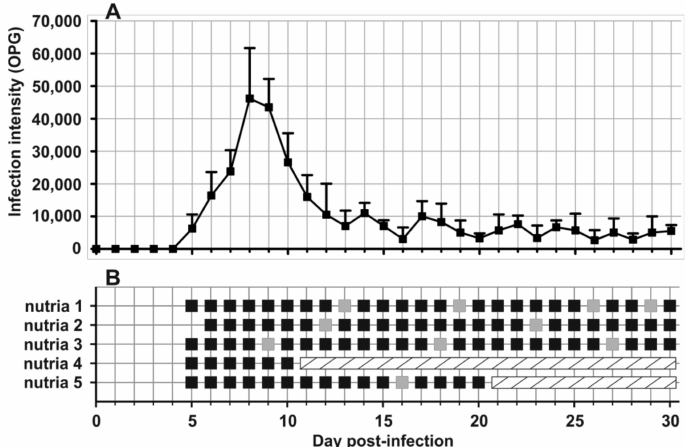
Figure 6. Course of infection of Cryptosporidium myocastoris n. sp. in experimentally inoculated nutria ( Myocastor coypu ). ( A ) Infection intensity expressed as number of oocysts per gram of faeces (OPG), and ( B ) detection of oocysts is based on molecular and microscopic examinations of faecal samples. Black squares indicate the presence of oocysts and specific Cryptosporidium myocastoris n. sp.; grey squares indicate the detection of specific DNA only without oocyst detection. Hatched rectangles indicate a missing animal due to sacrifice and